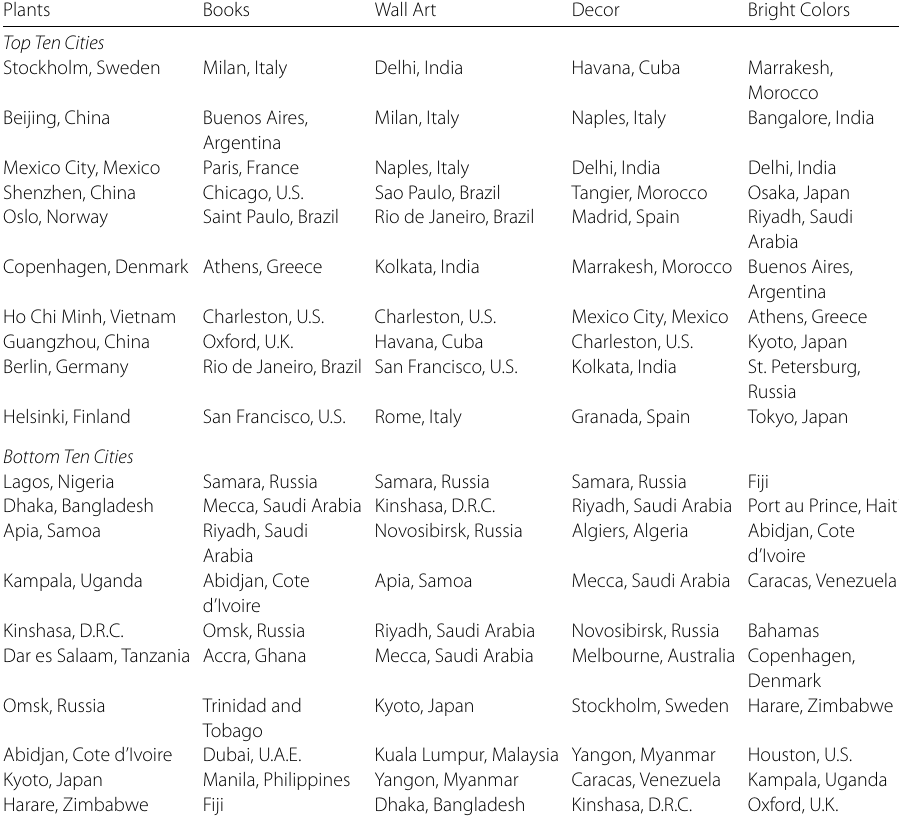
Table 3 Top and bottom global cities by presence of decorative elements Plants